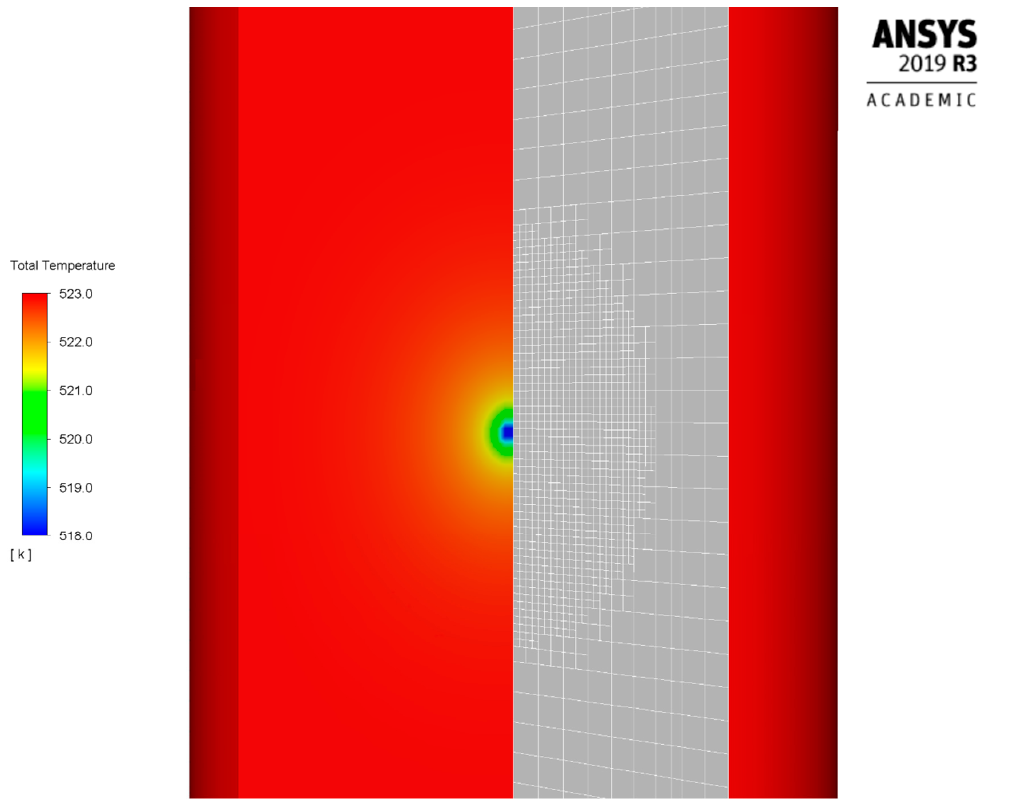
Figure 6. Mesh refinement and temperature profile of the urea–water solution behavior (UWS) droplet.